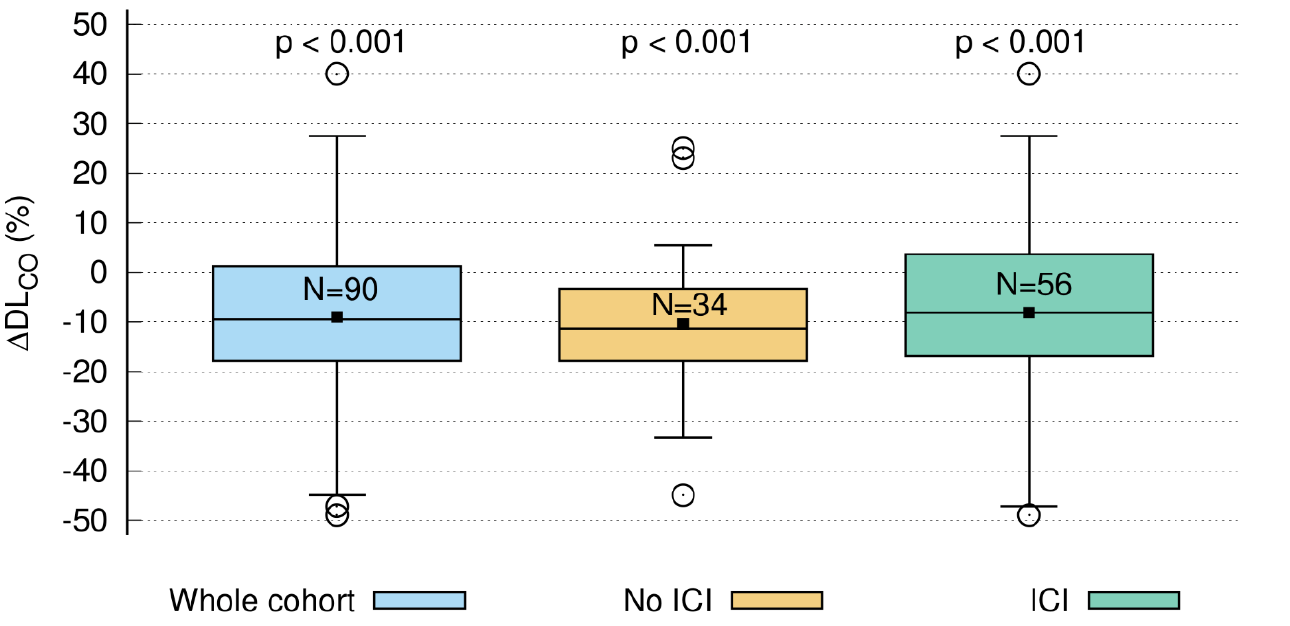
Figure 2. Relative decline in DLCO three months after radiotherapy compared to baseline (ΔDLCO): whole cohort (blue; n = 90), patients without ICI (=immune checkpoint inhibitor; brown; n = 34), and patients with ICI (green; n = 56). The decrease in DLCO (ΔDLCO) was significant for all three groups.